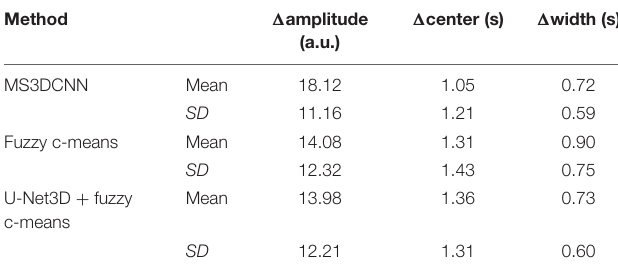
TABLE 3 | Mean and standard deviation of the difference between the automated methods and the manual method. Method